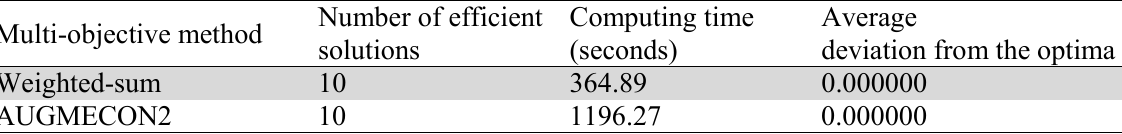
Results for the first scenario and ten grid points Multi-objective method